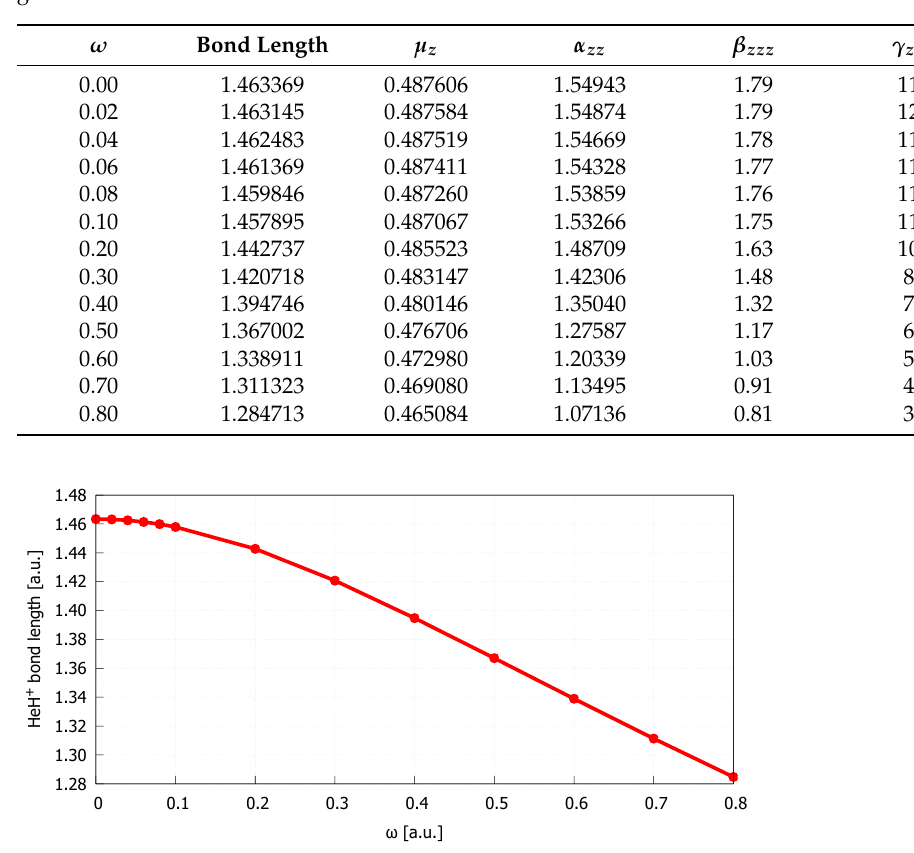
Figure 1. Bond lengths of HeH + embedded in cylindrically symmetric harmonic oscillator potential of ω strength obtained at the CCSD/aug-cc-pV6Z level of